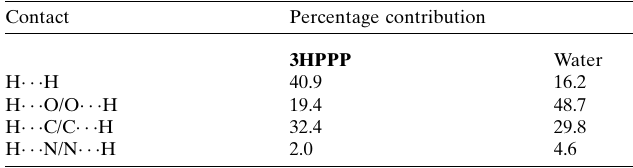
Table 2 Percentage contribution of interatomic contacts to the calculated Hirshfeld surfaces for the individual constituents in the asymmetric unit of 3HPPP